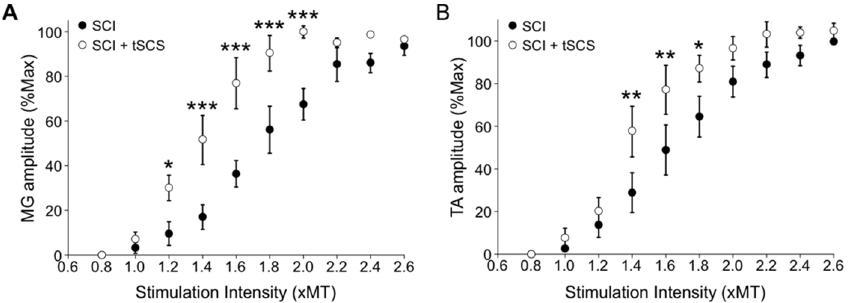
Figure 9. Repeated tSCS increases motor output after SCI. The recruitment curves of TEPs recorded in MG ( A ) and TA ( B ) show that the amplitude is larger in SCI + tSCS than SCI. * p < 0.05, ** p < 0.01, *** p < 0.001.